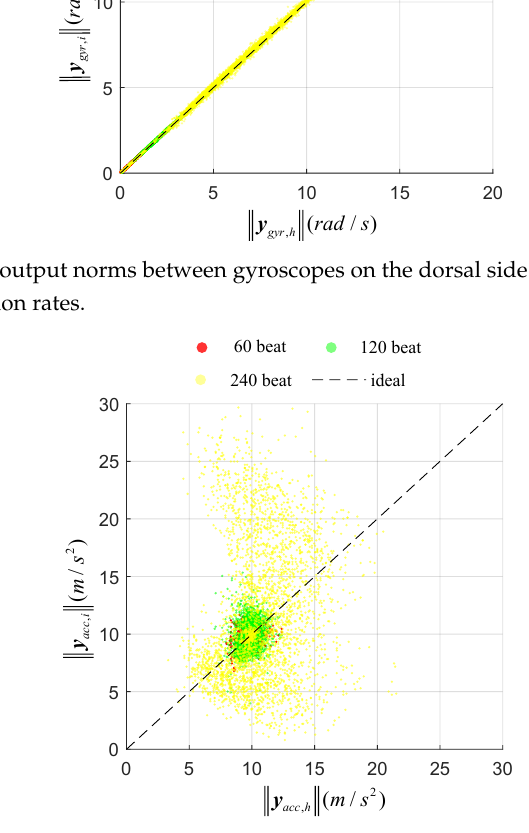
Figure 6. Relation of output norms between accelerometers on the dorsal side of the hand and finger tip with different repetition rates.